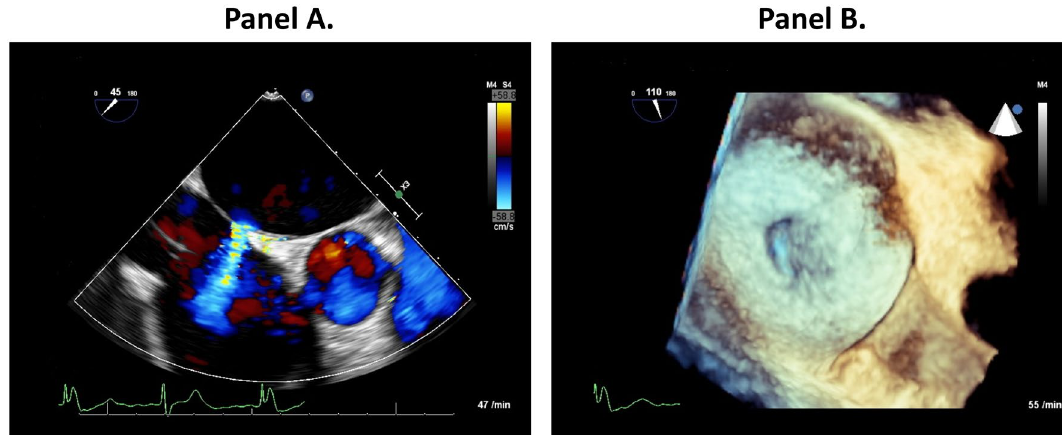
Figure 1. Iatrogenic atrial septal defect (iASD) at 6 months follow-up after MitraClip procedure. Panel ( A ) Transesophageal echocardiography with colour Doppler jet showing left to right shunting. Panel ( B ) 3D transesophageal echocardiography direct en-face imaging of the area of the iatrogenic atrial septal defect.